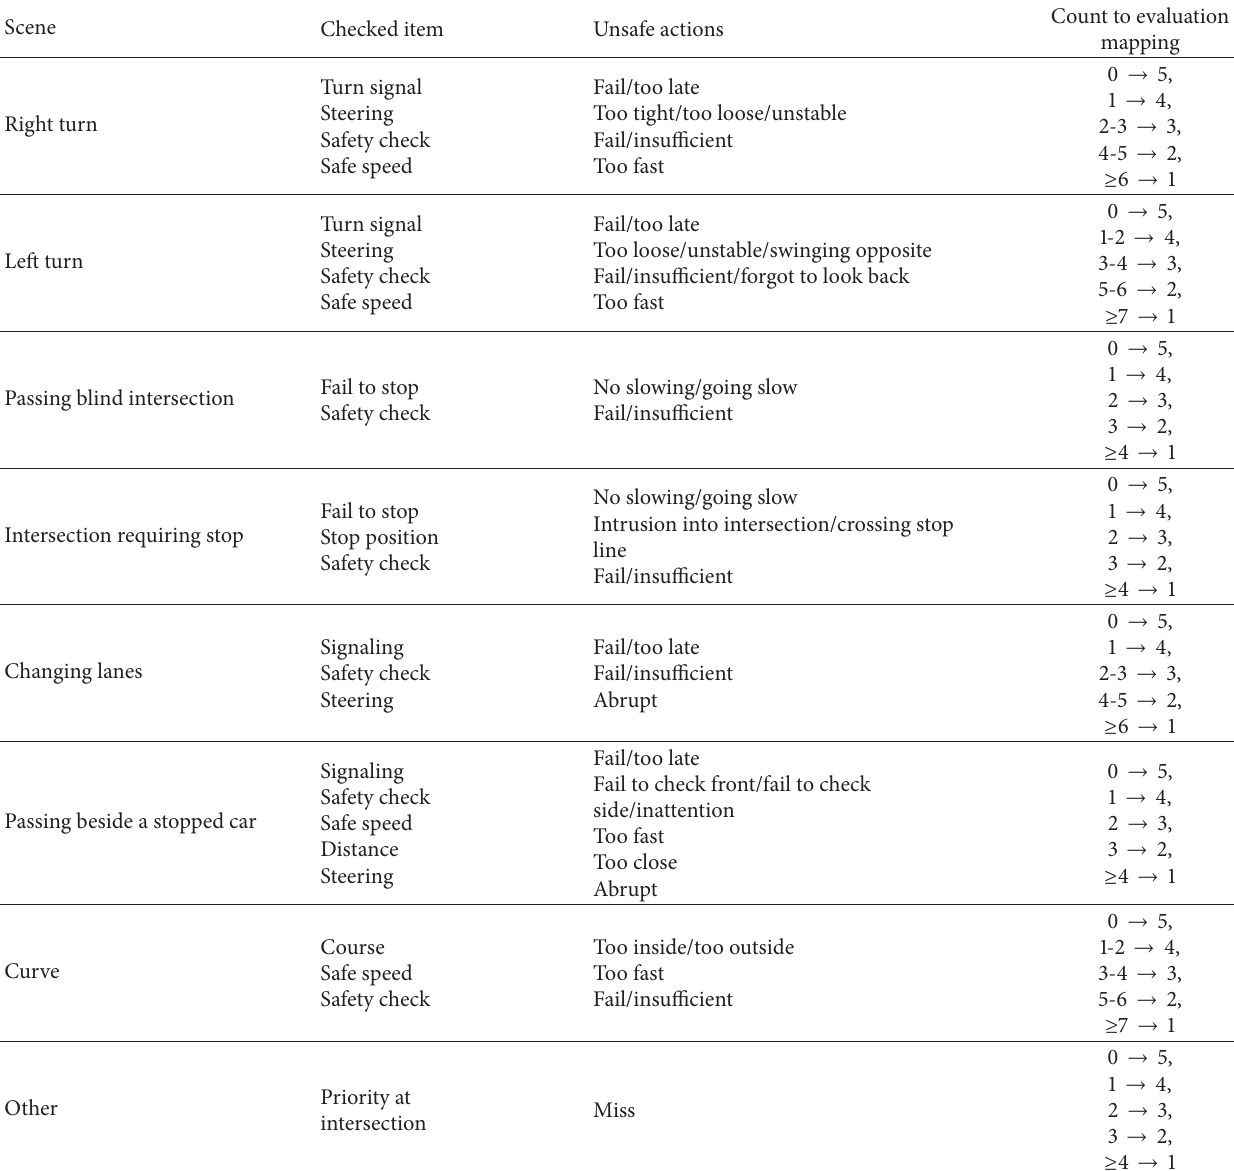
Table 3: Unsafe driving actions checked in the on-road